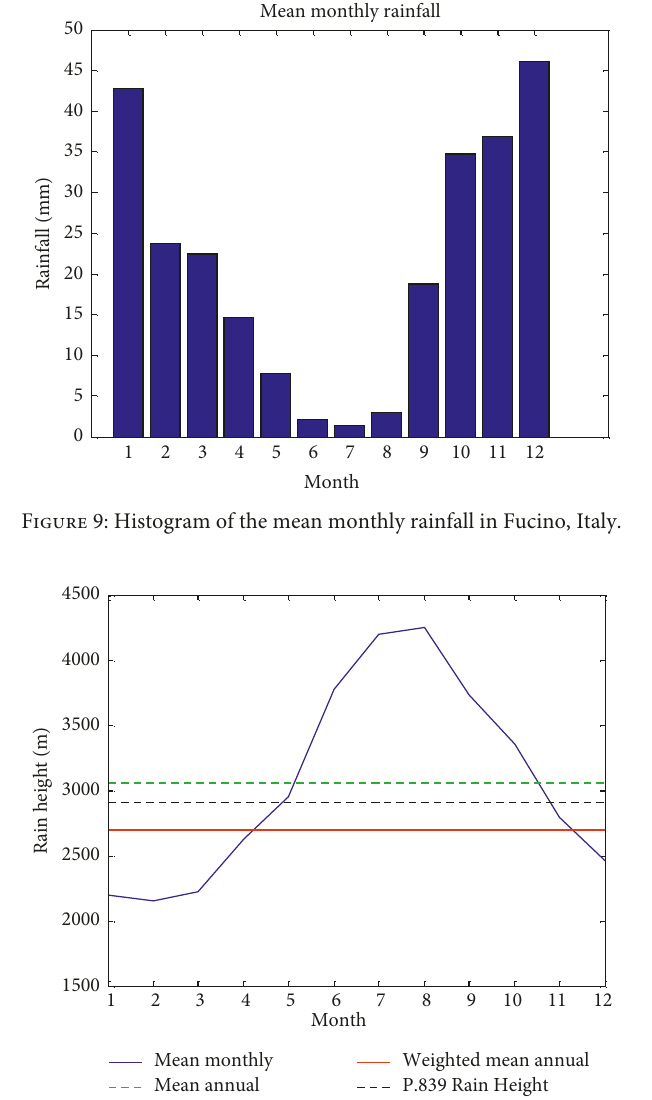
Figure 10: Comparison between different mean rain heights in Fucino, Italy.